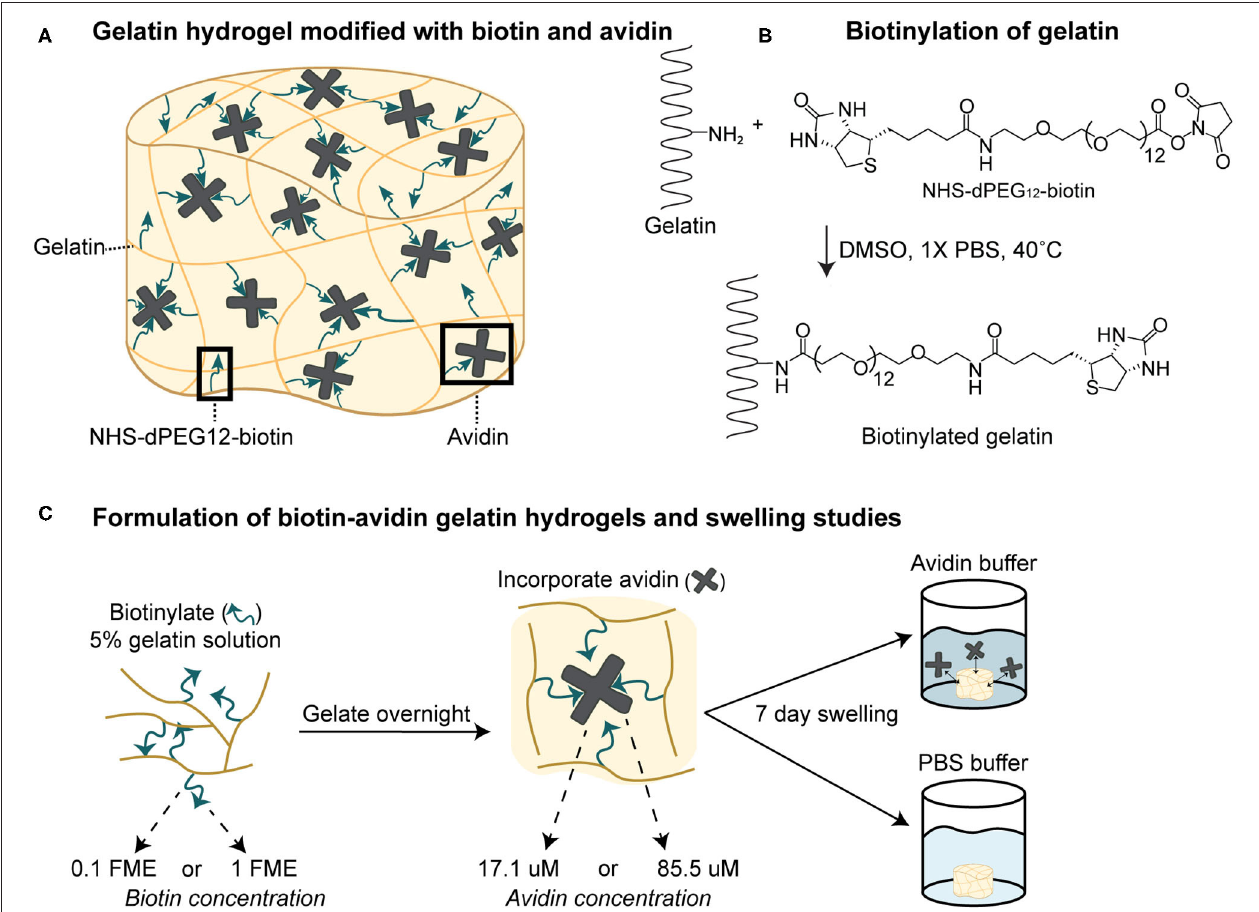
FIGURE 1 | Overview of the experimental design. (A) Gelatin hydrogels were modified with NHS-dPEG 12 -biotin and loaded with avidin to investigate biotin-avidin-mediated crosslinking. (B) Gelatin polymers were biotinylated by reaction with NHS-dPEG 12 -biotin via conjugation to primary amines on gelatin. MarvinSketch was used for illustrating chemical structures, substructures and reactions, Marvin 20.15.0, 2020, ChemAxon (http://www.chemaxon.com). (C) Hydrogels were formed by allowing biotinylated gelatin polymers, prepared with 0.1 or 1 fold molar excesses (FME) of biotinylation reagent, to gelate overnight. Then, they were either placed directly into 17.1 or 85.5 µ M avidin solutions for swelling studies in the presence of avidin or incubated overnight in 85.5 µ M avidin prior to swelling studies in PBS to evaluate biotin-avidin